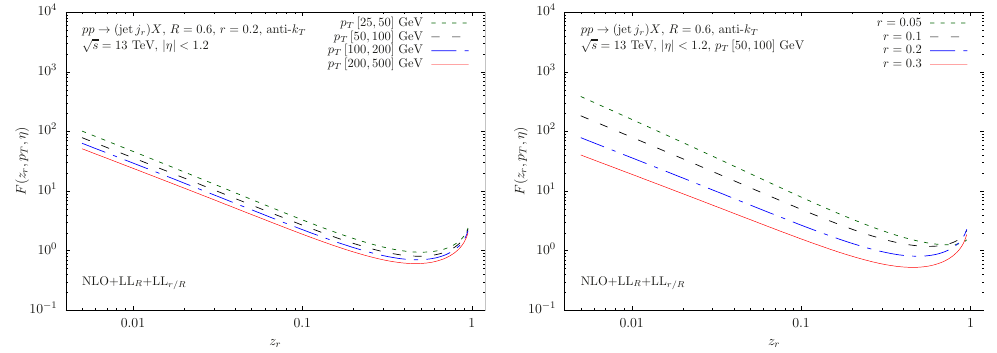
Figure 6 . Left: same as (cid:12)gure 5 but without multiplying the result for the di(cid:11)erent p T intervals by multiples of 10. Right: subjet distribution measured on an inclusive jet sample, using the same kinematics as in (cid:12)gure 5 and the p T bin of [50 ; 100] GeV. The distribution is shown for di(cid:11)erent values of the subjet radius: r = 0 : 05 (green dotted), r = 0 : 1 (black dashed), r = 0 : 2 (blue dot- dashed) and r = 0 : 3 (red